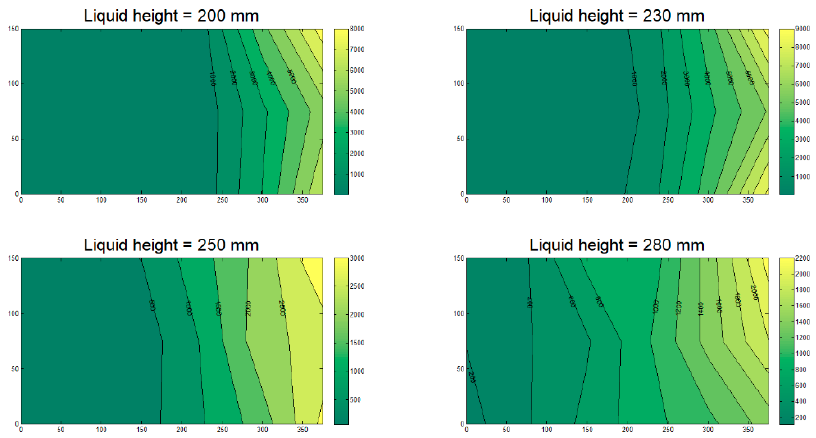
Figure 7. Pressure distribution at the roof of the 755 mm × 300 mm tank, 0° orientation.